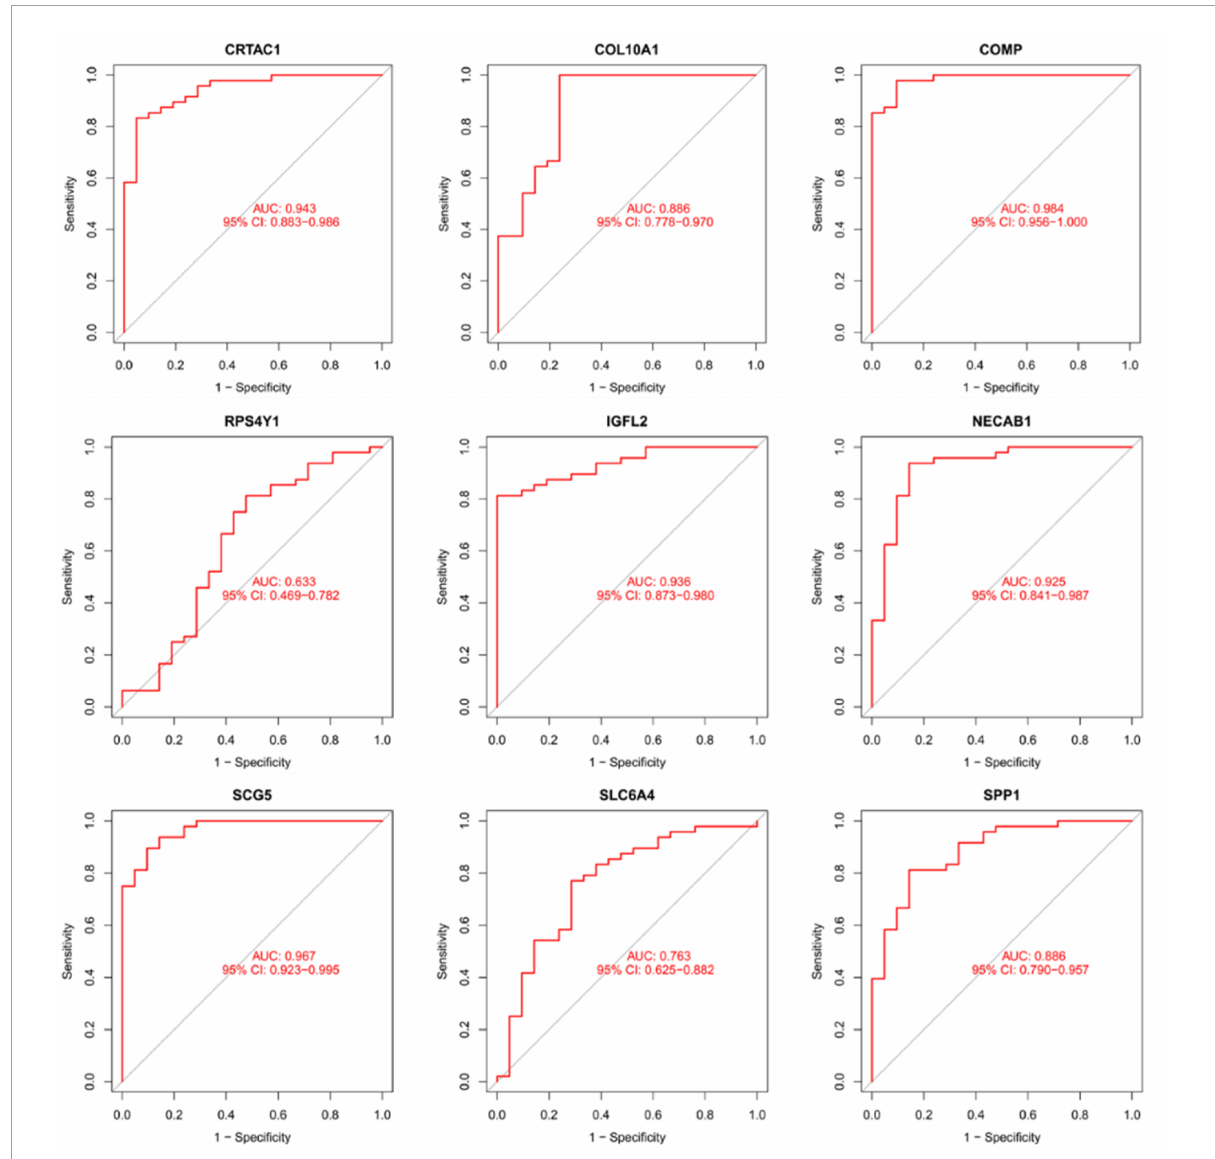
FIGURE10 The receiver manipulation characteristic (ROC) curves for diagnostic validity of nine diagnostic markers in the metadata queue.